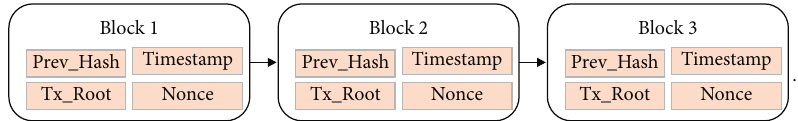
Figure 2: Structure of a blockchain.